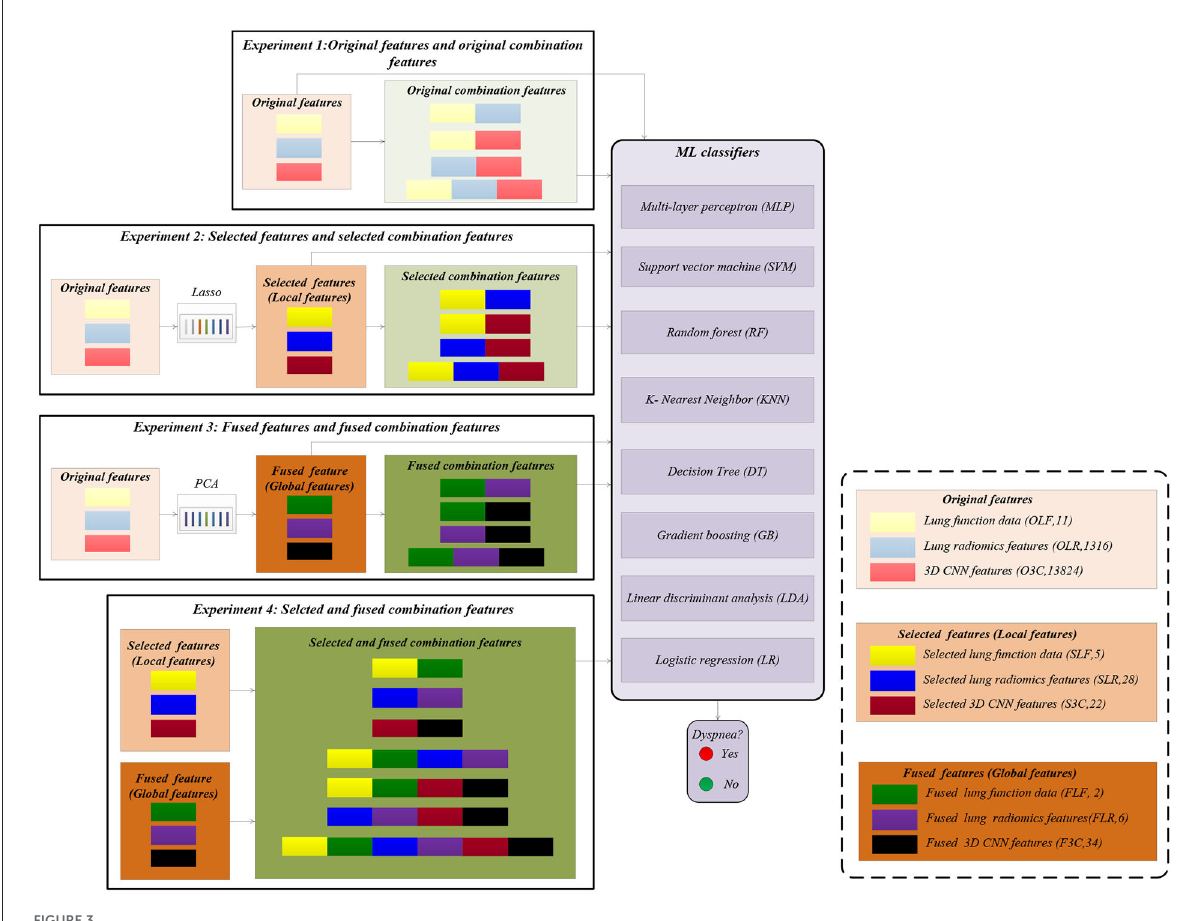
FIGURE3 Experimental design in this